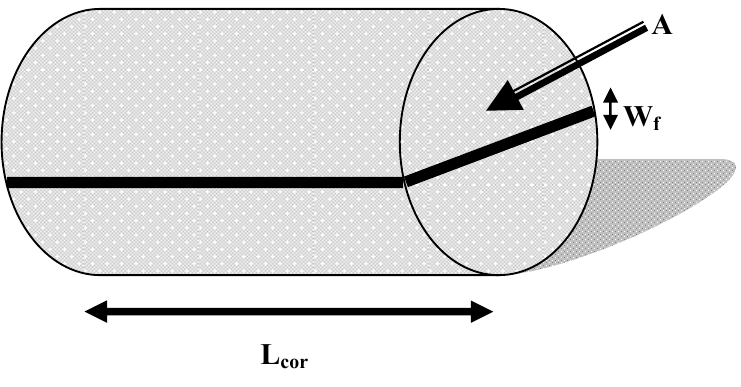
Figure 2. The configuration of the fractured core